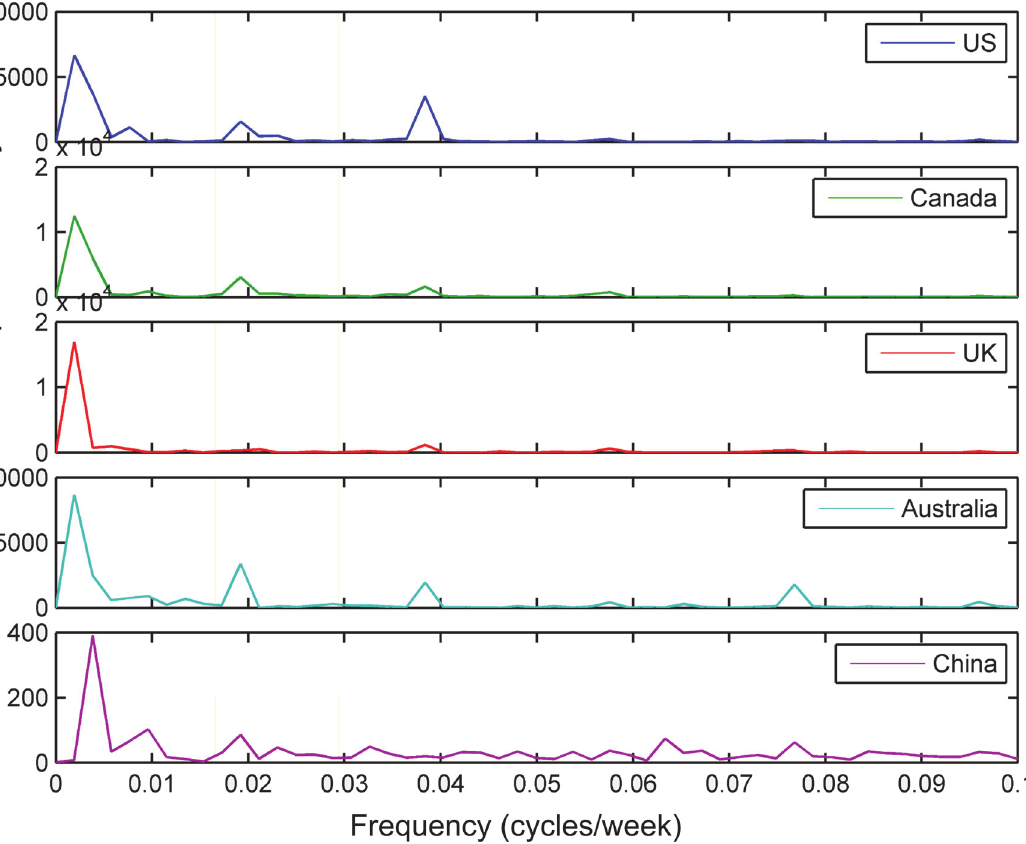
Fig 2. Periodograms of the tobacco-related search trends of the USA, Canada, the UK, Australia, and China. A peak in the periodogram indicates there is a seasonal component near the value corresponding to the peak.